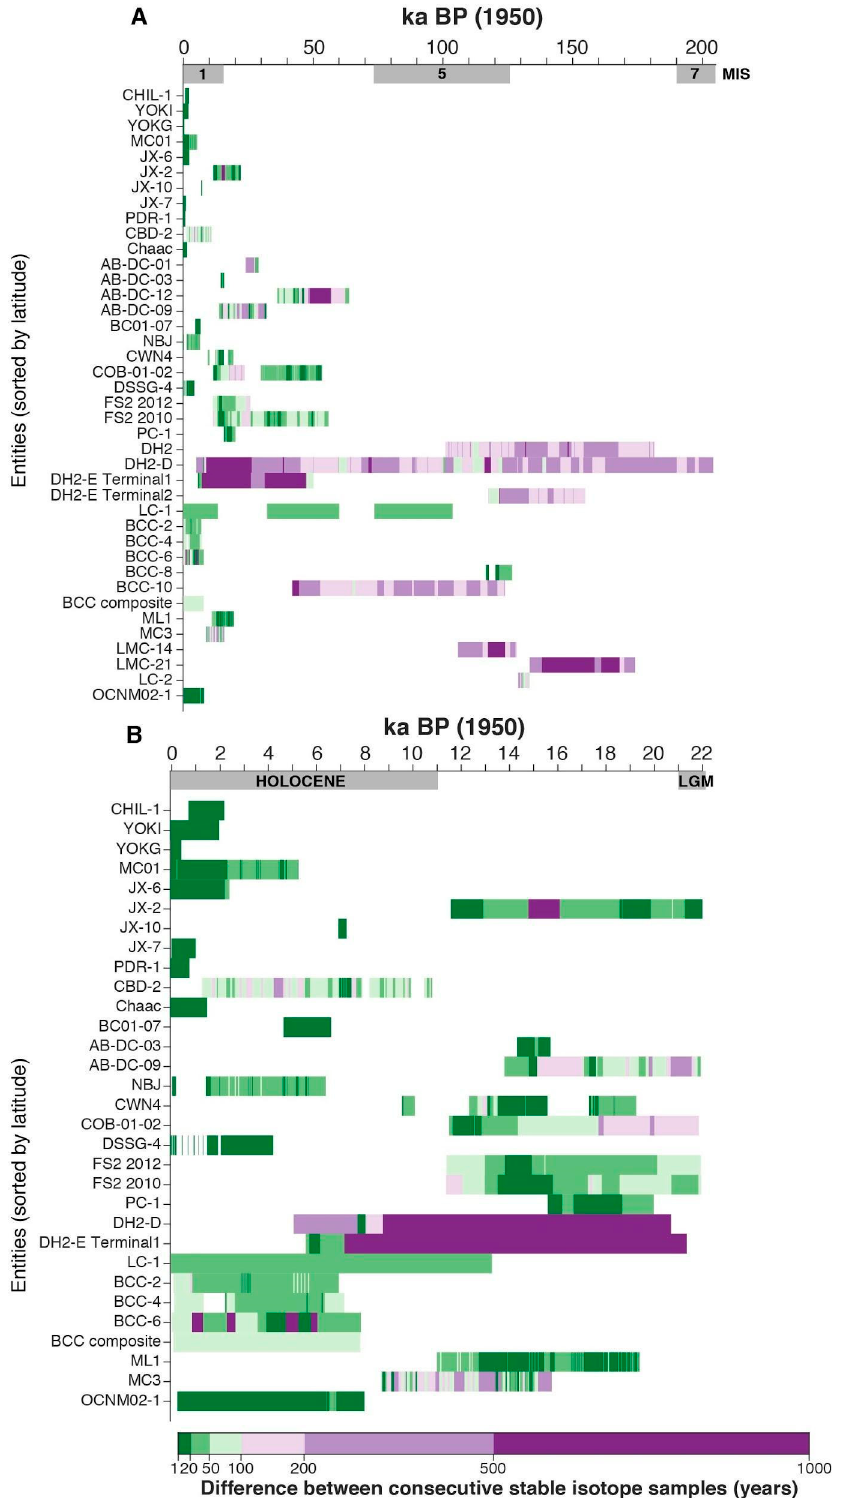
Figure 3. Temporal coverage of North and Central American speleothem records represented in SISAL_v1 for all records ( A ) and covering only the last 22 ka ( B ). Shading denotes temporal resolution within records given as the time difference between two consecutive stable isotope samples in years. Hiatuses in individual records are shown by blank spaces.